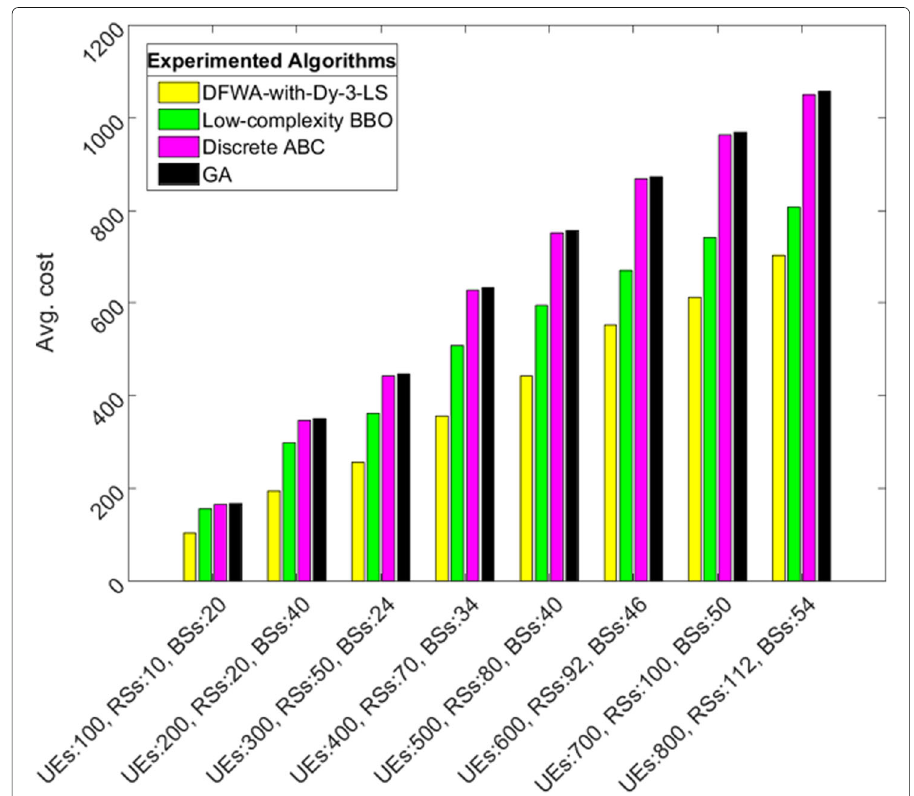
Fig. 3 Average cost for the experimented